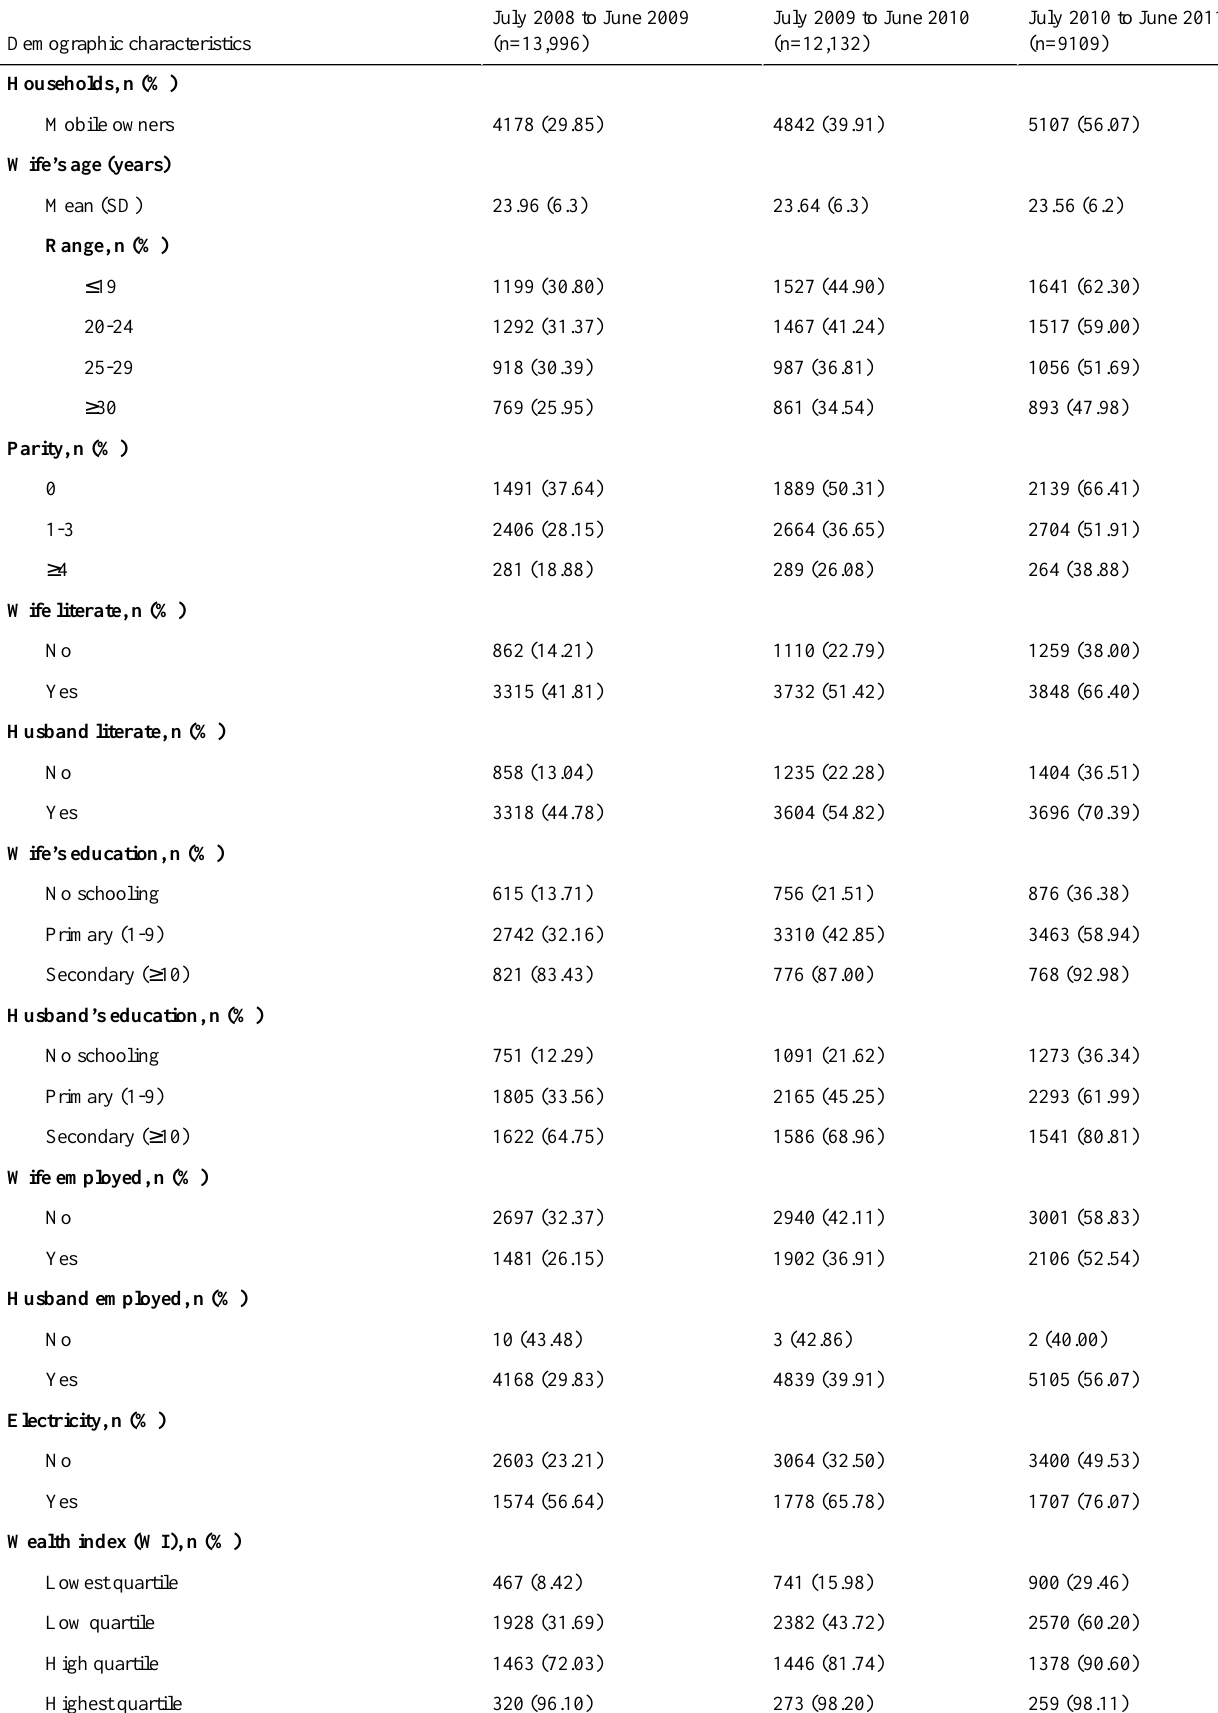
Table 3. Demographic characteristics of mobile phone owners by fiscal year,